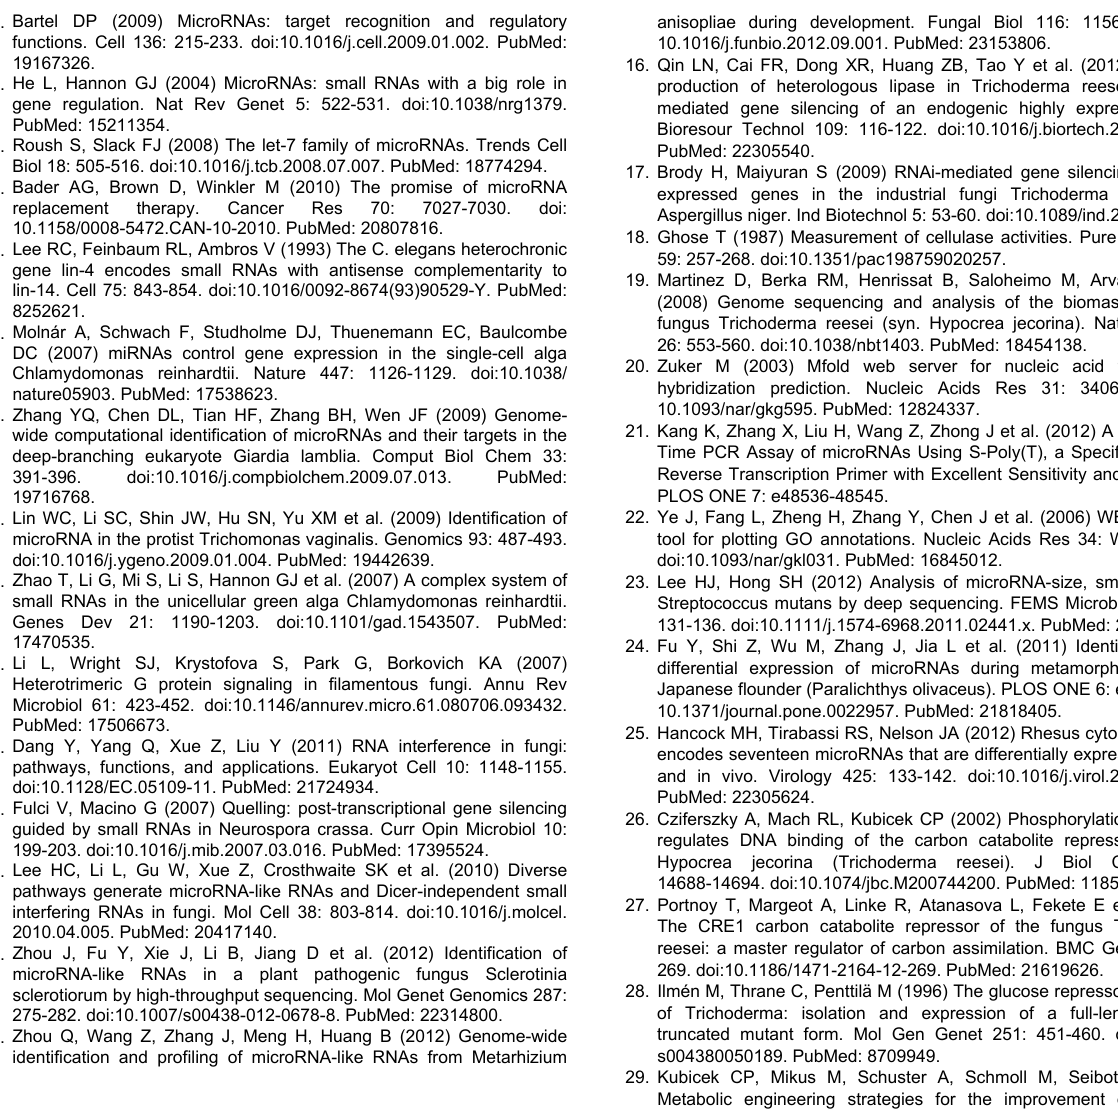
Table S3. Components involved in the sRNA biogenesis of T. reesei and two other filamentous fungi.